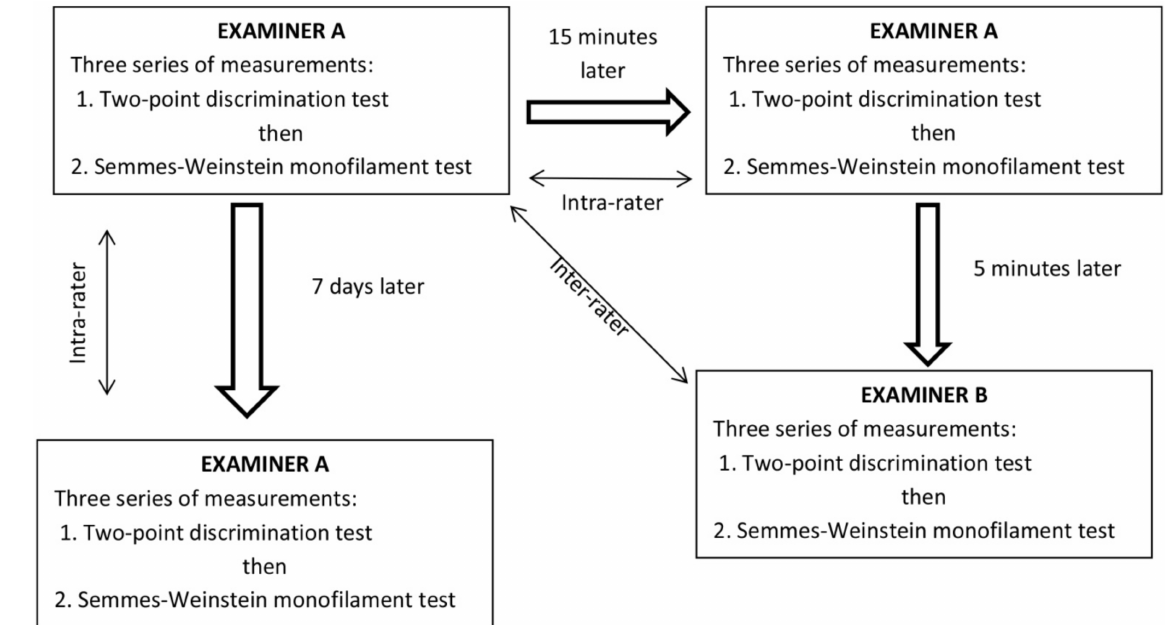
Figure 1. Structure of